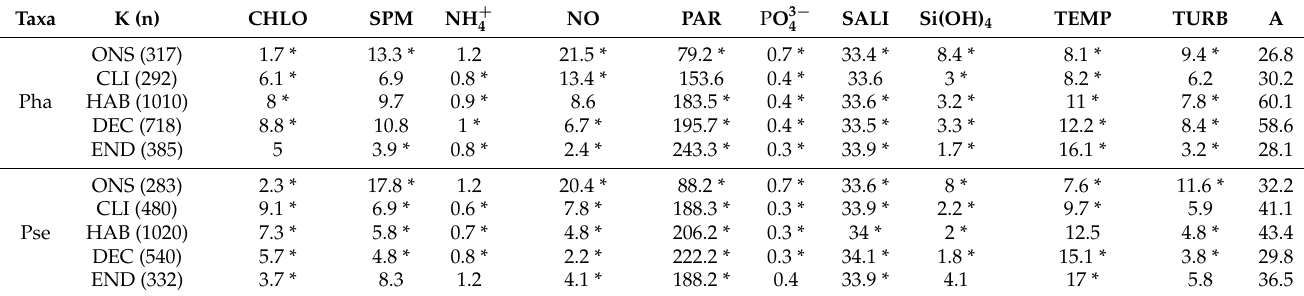
Table 5. Environmental parameters mean value and significance by phenological subset K: onset (ONS), the climax (CLI), the harmful stage (HAB), the decline (DEC) and the end (END) for each of the harmful taxa; Phaeocystis globosa (Pha) and the complex Pseudo-nitzchia spp (Pse). The number of samples by subset K corresponds to n and the significance is of p < 0.05 represented by the *. A is the area of the subset K polygon in Figure